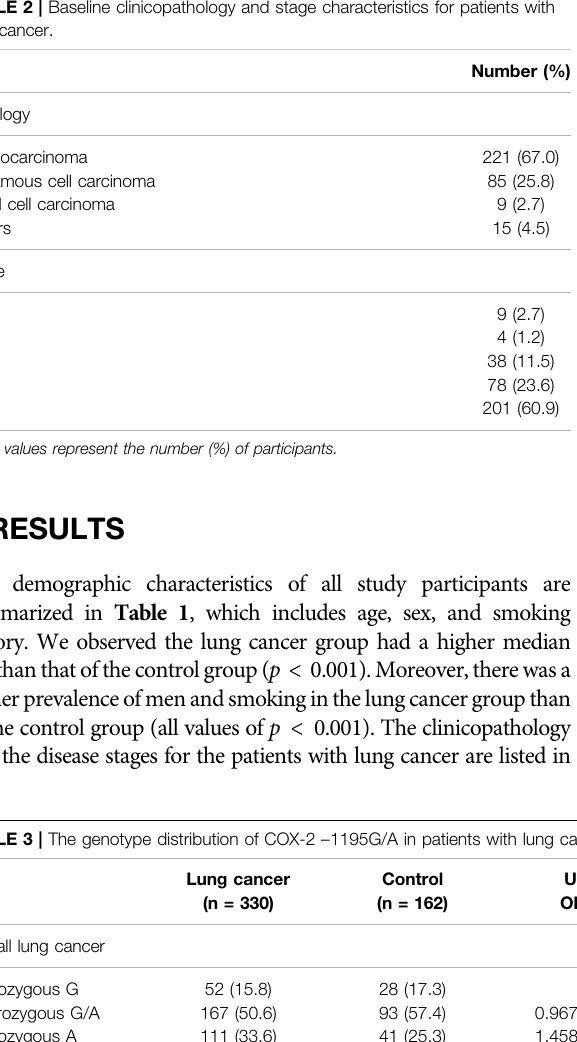
Table 2 . Adenocarcinoma, squamous cell carcinoma, small cell carcinoma, and the others represented 67, 25.8, 2.7, and 4.5% of all patients with lung cancer, respectively. Stage I + II, stage III, and stage IV represented 3.9, 35.1, and 60.9% of all patients with lung cancer, respectively. The 330 patients with lung cancer and 162 healthy controls were genotyped for the COX-2 – 1195G/A polymorphism ( Table 3 ). The genotype distribution in the control group was consistent with the Hardy-Weinberg equilibrium. Moreover, for the genotype distribution of COX-2 – 1195G/A, there is no signi fi cant difference between lung cancer patients and the controls ( p = 0.17), and also no signi fi cant difference was obsearved between the adenocarcinoma group and the squamous cell carcinoma group ( p = 0.158).